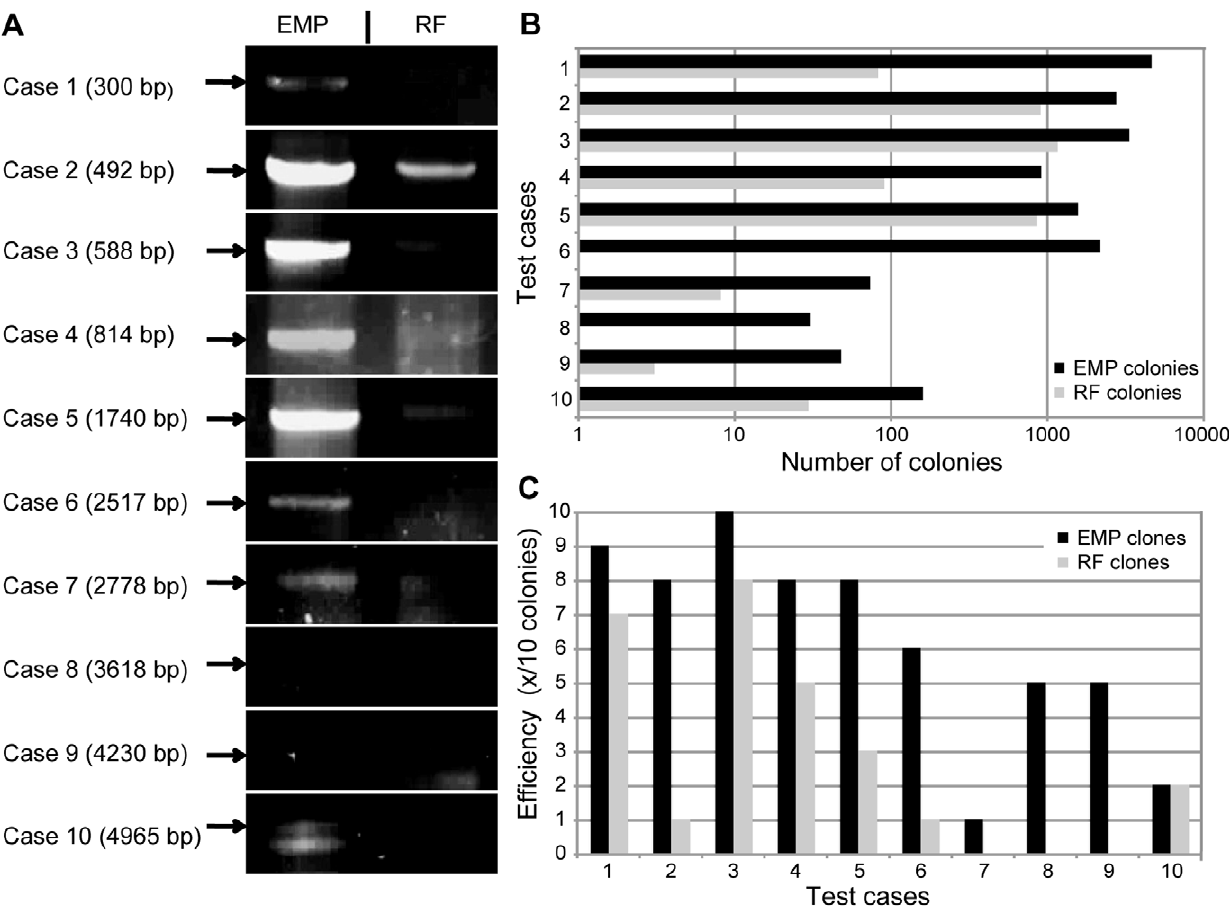
Figure 4. Cloning efficiency of EMP and RF cloning. Cloning efficiency of EMP and RF cloning are compared. (A) Agarose gel band intensities of 2 nd EMP and 2 nd RF PCR reactions of 10 test cases are compared (insert length in parentheses). Complete agarose gels are shown in Figure S1 . (B) The number of colonies obtained with EMP and RF cloning are compared (notice that the axis is logarithmic). (C) The cloning efficiency, depicted in number of correct clones of 10 analyzed, is compared for EMP and RF cloning. Agarose gels of restriction digests are shown in Figure S2